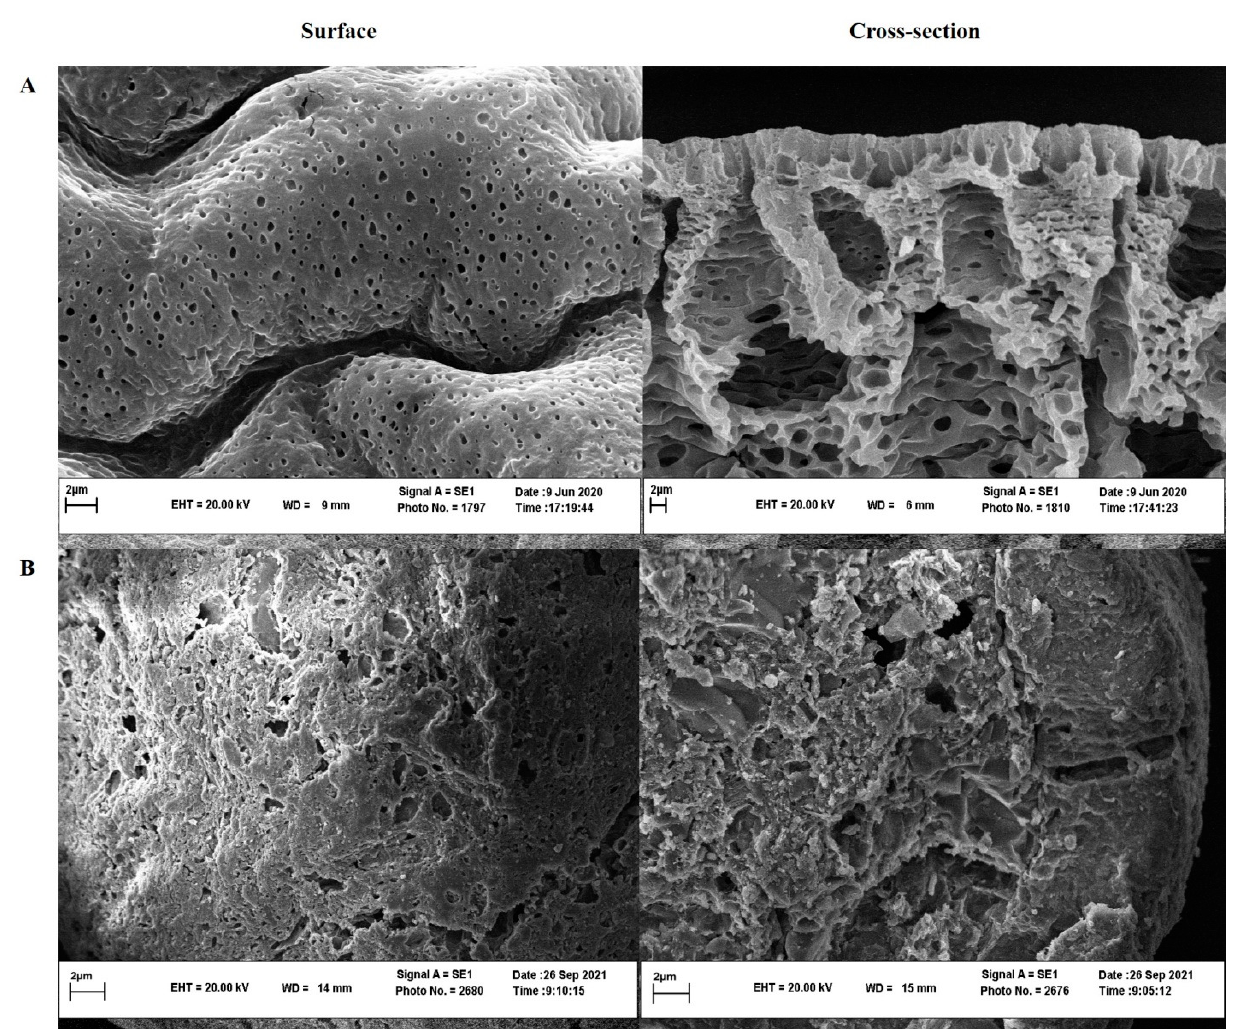
Figure 2. Cross and surface morphologies of ISFI ( A ) and ISFG ( B ) using